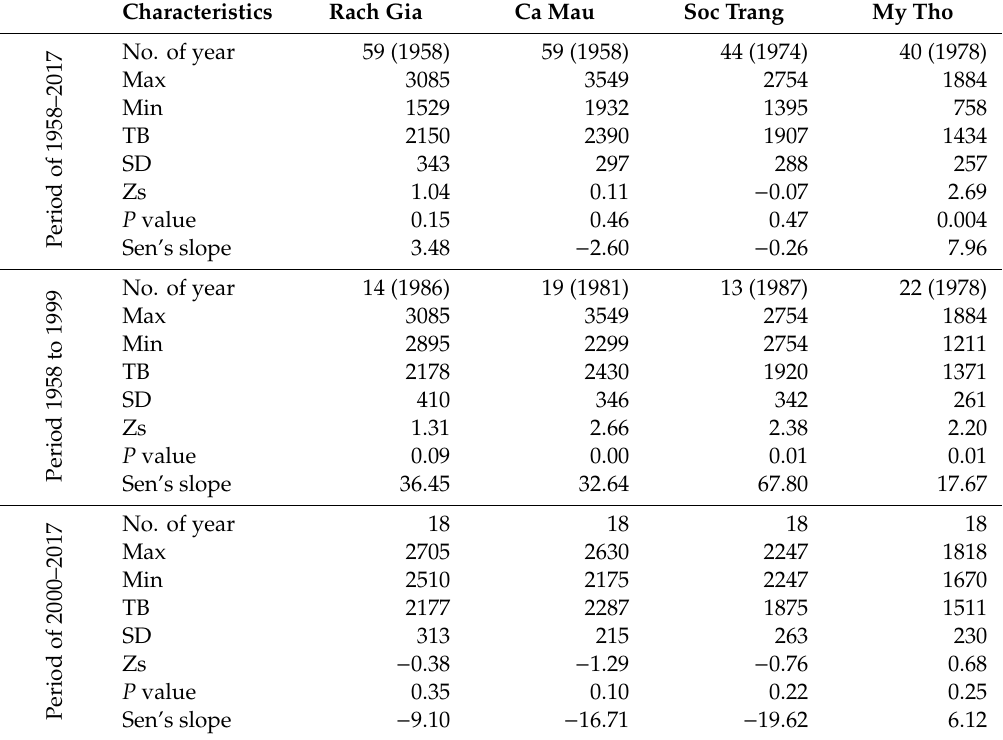
Table A3. Results of trend test of rainfall characteristics at four rain stations for di ff erent periods.